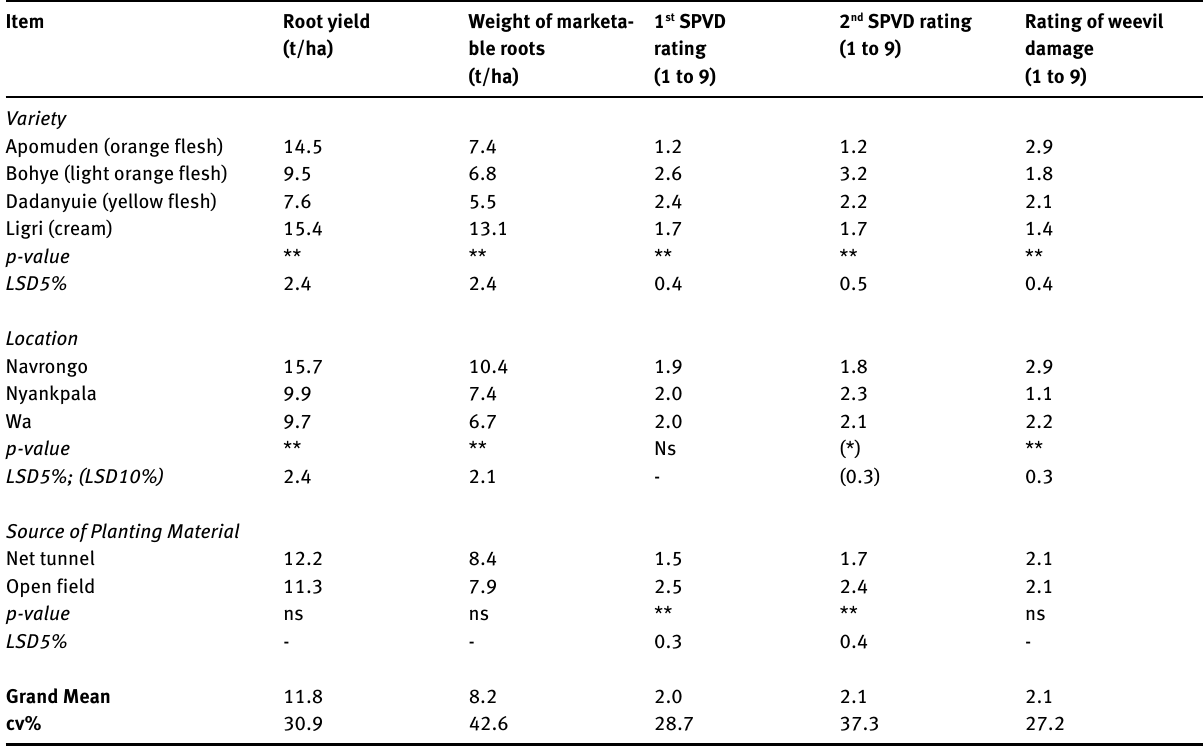
Table 3: Storage root yield (t/ha), weight of marketable roots (t/ha), rating of the first and second observation for SPVD and rating for weevil damage